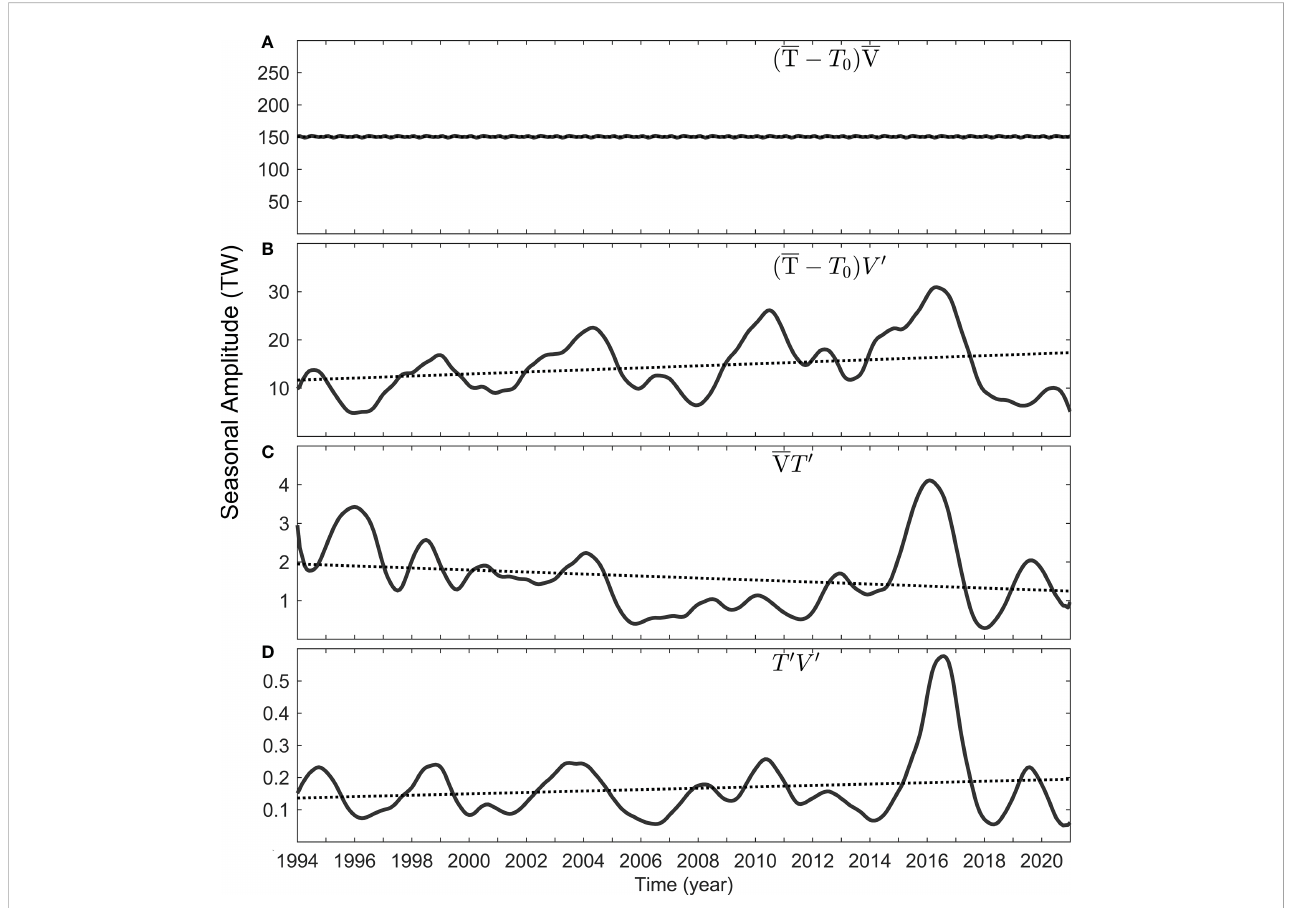
FIGURE 9 The Seasonal amplitude time series of (A) climatologic state, (B) velocity anomaly, (C) temperature anomaly, and (D) higher-order terms in the formula of heat transport. These seasonal amplitudes are extracted using the harmonic algorithm (Method 2). The time series in (B) , (C) , and (D) are smoothed by 13-month moving average before